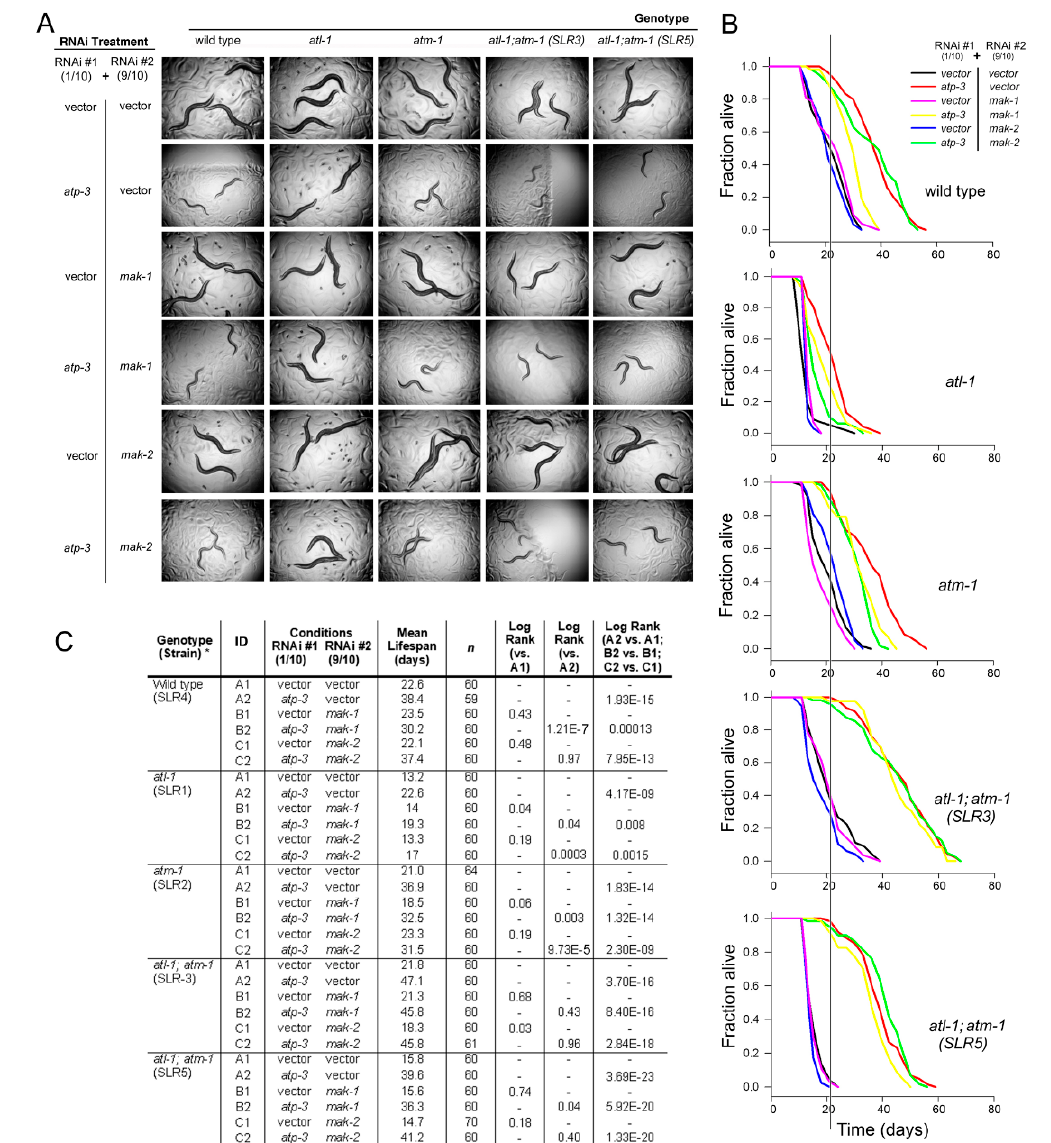
Figure 2. MAPKAP kinases are active following mitochondrial respiratory chain stress. ( A – C ) The MAPKAP kinases MAK-1 and MAK-2 play no role in size control of worms exposed to 1/10th strength atp-3 feeding RNAi ( A ); however, they do control lifespan in wild type worms and in atm-1 (gk186) and atl-1(tm853) single gene mutants ( B , C ). Worms in ( A , B ) were established independently using a total of 8000 and 32,000 synchronized eggs, respectively, and all conditions in each panel were tested in parallel. In ( A ), worms were photographed at the same chronological point. In ( B ), the vertical line marks median survival of wild type worms on vector control RNAi. In ( A – C ), all worms are the unbalanced F1 progeny of parents carrying the nT1 reciprocal chromosomal translocation. * Full genotypic information provided in Table S4.